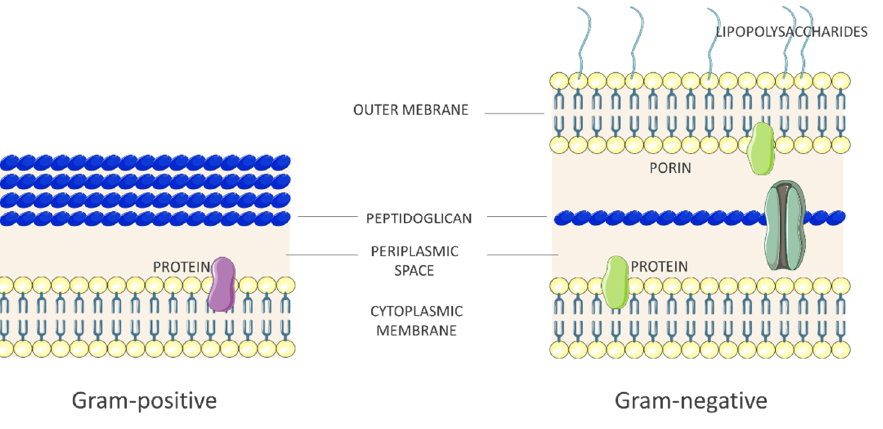
Figure 2. Gram-negative versus Gram-positive cell walls.